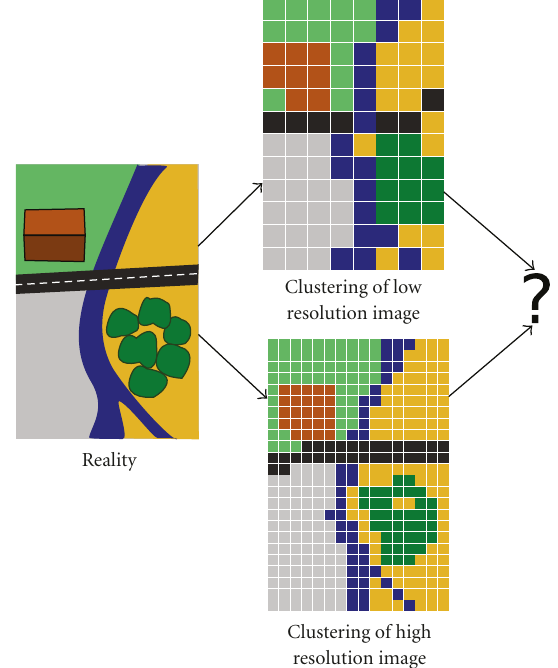
Figure 6: How can someone compare objects that are di ff erent but that represent a same “real” object? A same reality is viewed at two di ff erent resolutions. For example the river is composed of 17 pixels on the low resolution image but it is composed of 43 pixels on the high resolution